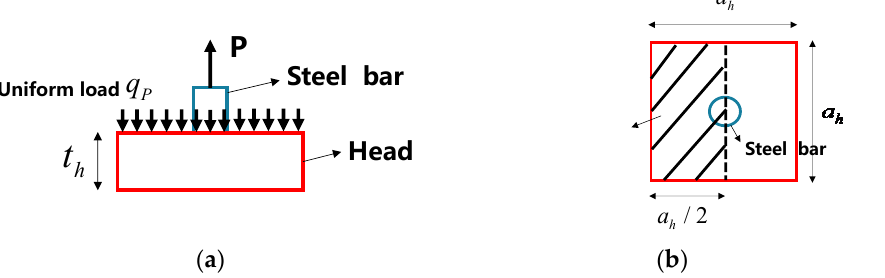
Figure 39. Analytical model to determine head thickness ( a ) Load on head; ( b ) Plan view of head.